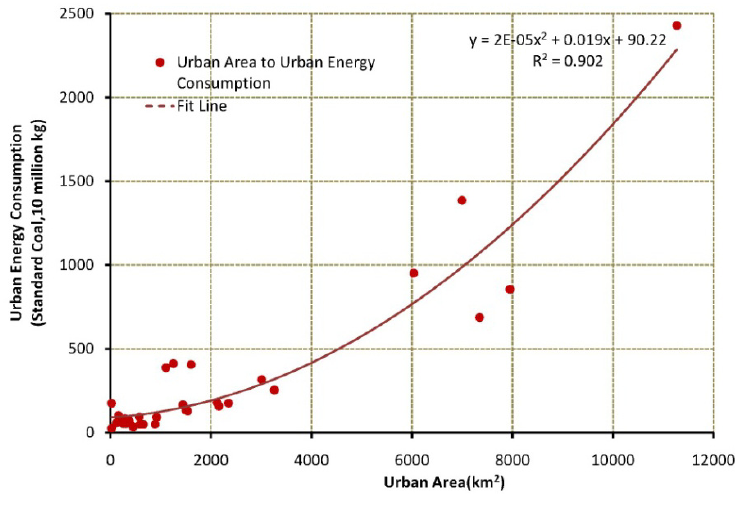
Figure 2. Exponential relationship between urban area and energy consumption by city scale (data of urban areas and energy consumption are provided by NBSC, which is used to fit energy consumption to urban